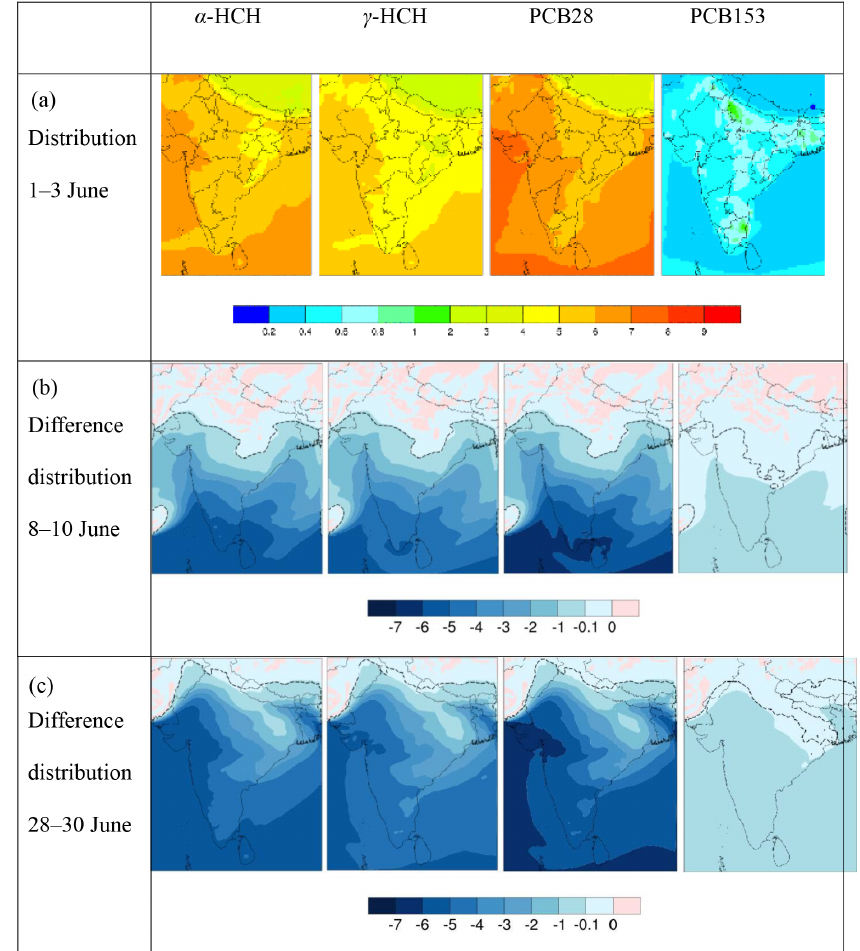
Figure 3. Air pollutant distributions. α -HCH, γ -HCH, PCB28 and PCB153 (pgm − 3 ) predicted concentrations in near-ground air prior to monsoon onset (1–3 June, a ) and difference distributions due to monsoon advection (experiment – control; b : 8–10 June, c : 28–30 June 2014). The difference is significant ( p <0.05, t test) south of the dotted